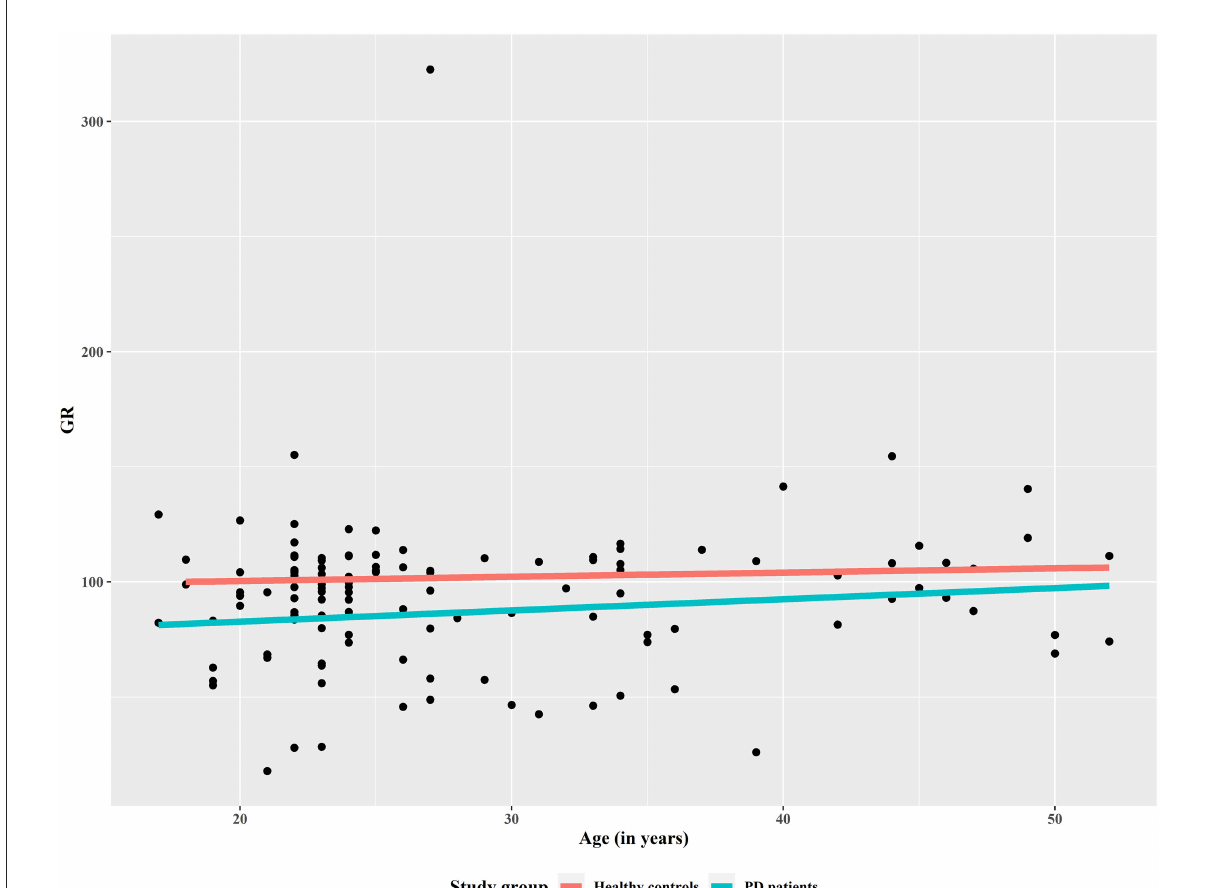
FIGURE1 Predictors in the regression analysis to explain glucocorticoid receptor expression, controlled for the antipsychotic prescription. This regression model showed a lower Akaike information criterion (AIC = 79.96) than the unconstrained model (AIC = 83.47) and the model with sociodemographic predictors (AIC = 86.77).